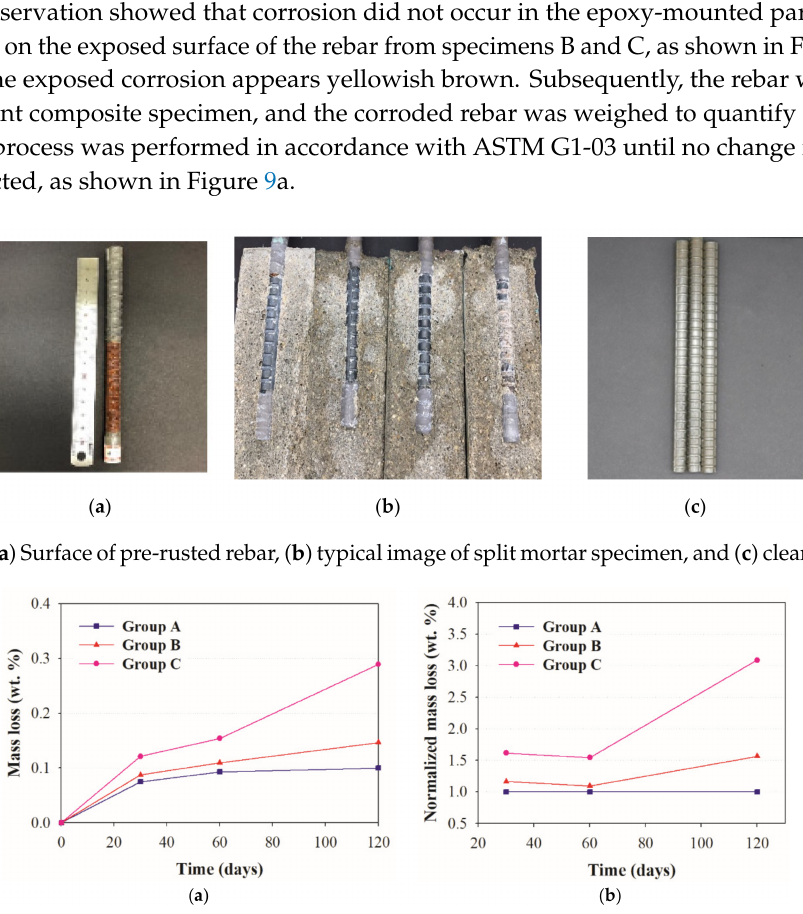
Figure 9. ( a ) Mass loss (wt %) vs. time; ( b ) normalization mass loss (wt %) vs.